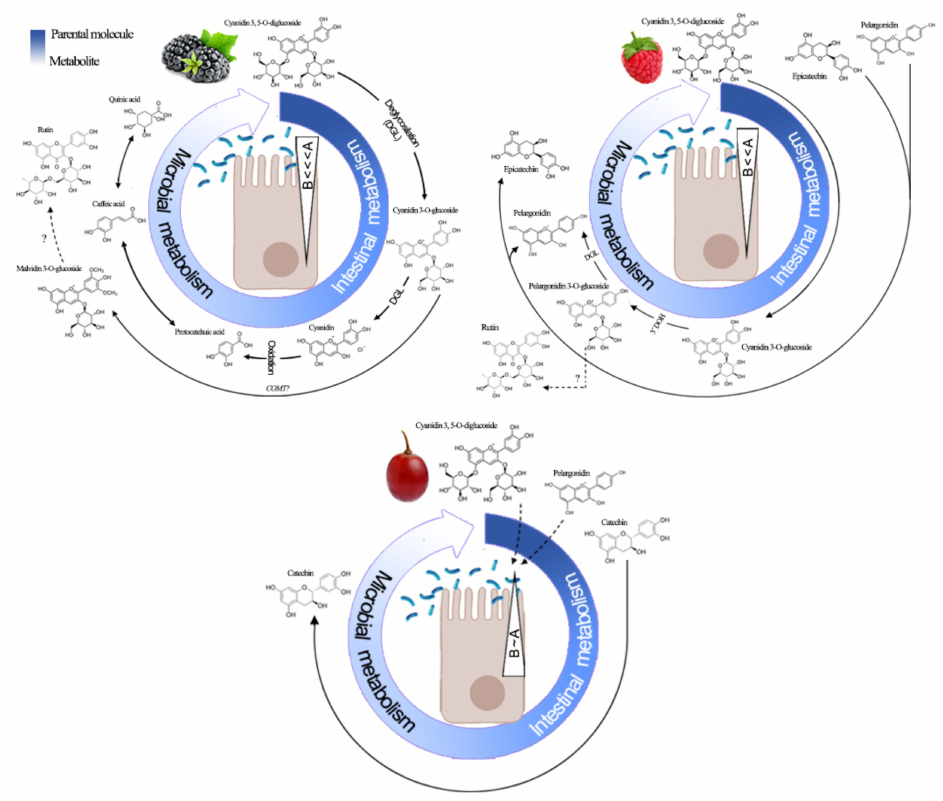
Figure 4. First-pass metabolism of polyphenols from blackberry, raspberry and Red Globe grape. Stepwise metabolite production from parental polyphenols (Table 1) detected by HPLC-ESI-QTOF-MS (both, below (Table 3) and over (Table S2) a signal-to-noise 10:1 ratio results from a concerted action of epithelial enzyme machinery and jejunal microflora. Triangle magnitude and direction (A < ~ > B) is derived from Table 2. Apical (A), basolateral (B), catechol- O -methyltransferase (COMT), 3’ hydroxyl removal (3’DOH), deglycosylation